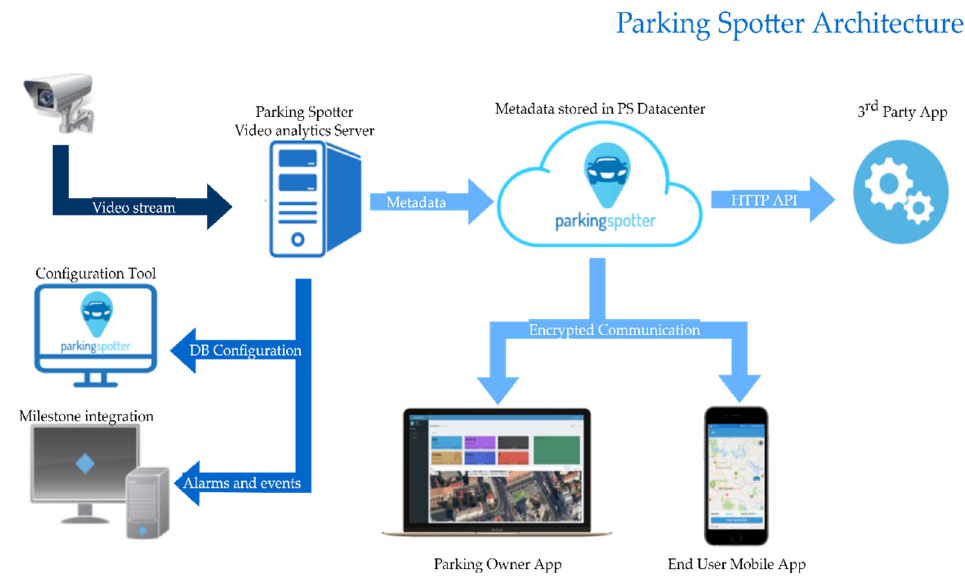
Figure 3. Parking spotter